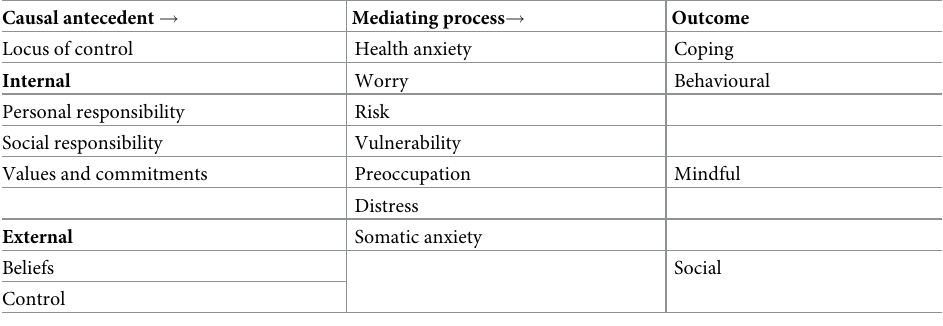
Table 1. Model of health anxiety